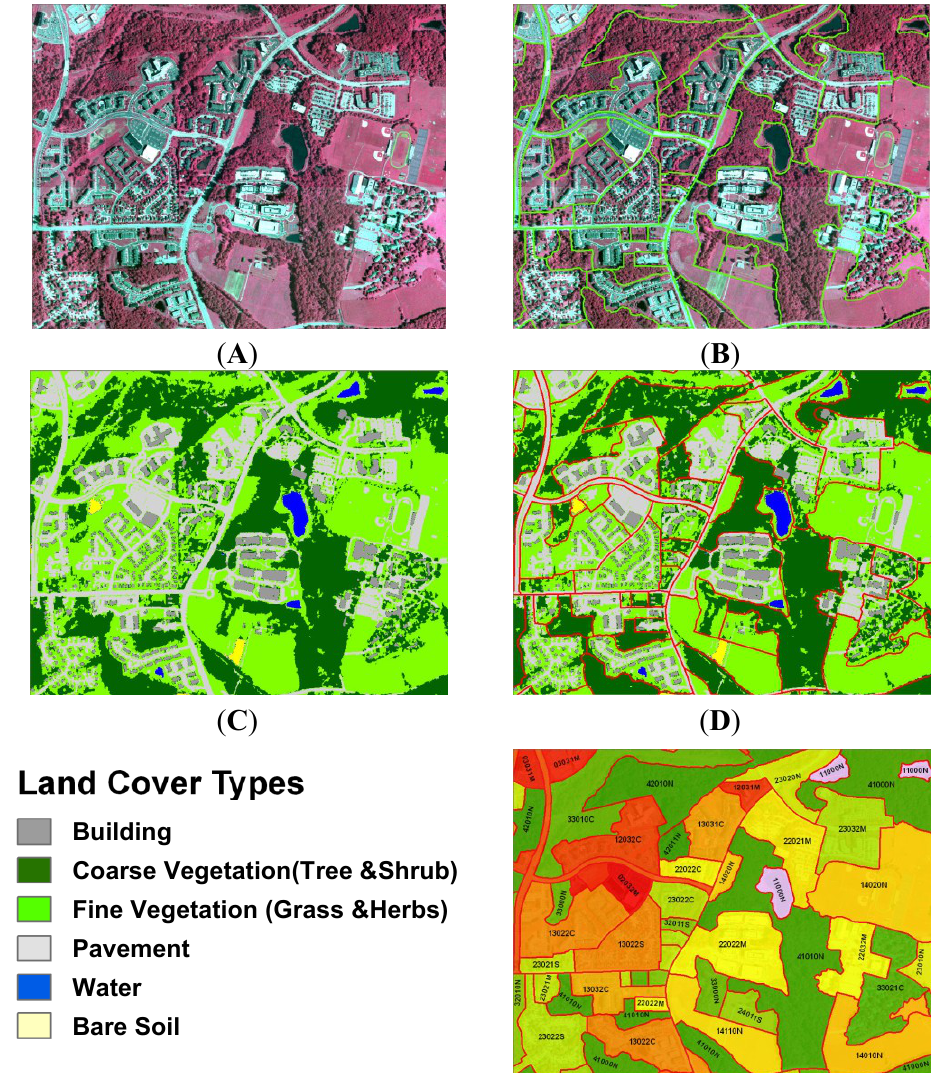
Figure 2. The process of patch delineation and classification. Panel ( A ): the false-color aerial imagery of an urban landscape with mixed built and non-built components; Panel ( B ): the patches delineated based on the HERCULES classification scheme; Panel ( C ): classification of the six types of landscape features (or land cover) based on an object-based classification approach; Panel ( D ): land cover classification with the patches overlaid; Panel ( E ): patch classification based on the proportional cover of within-patch landscape